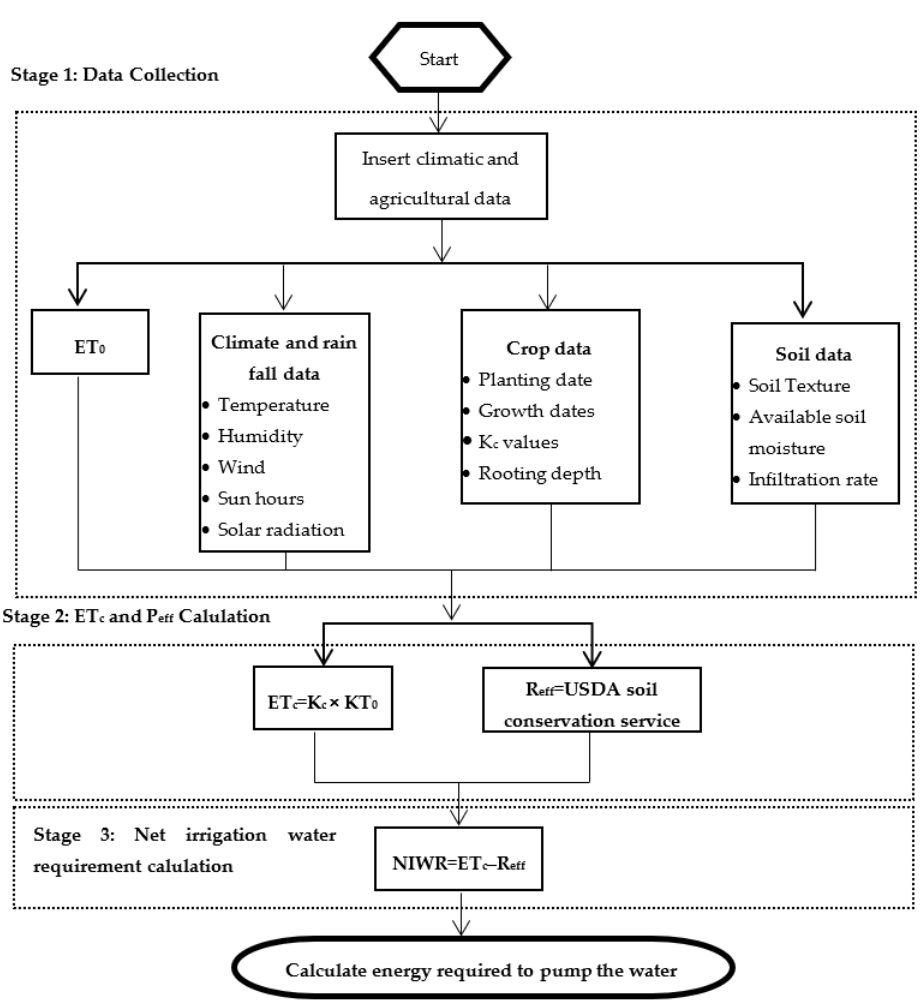
Figure 9. Flow chart of the crop water requirements and energy